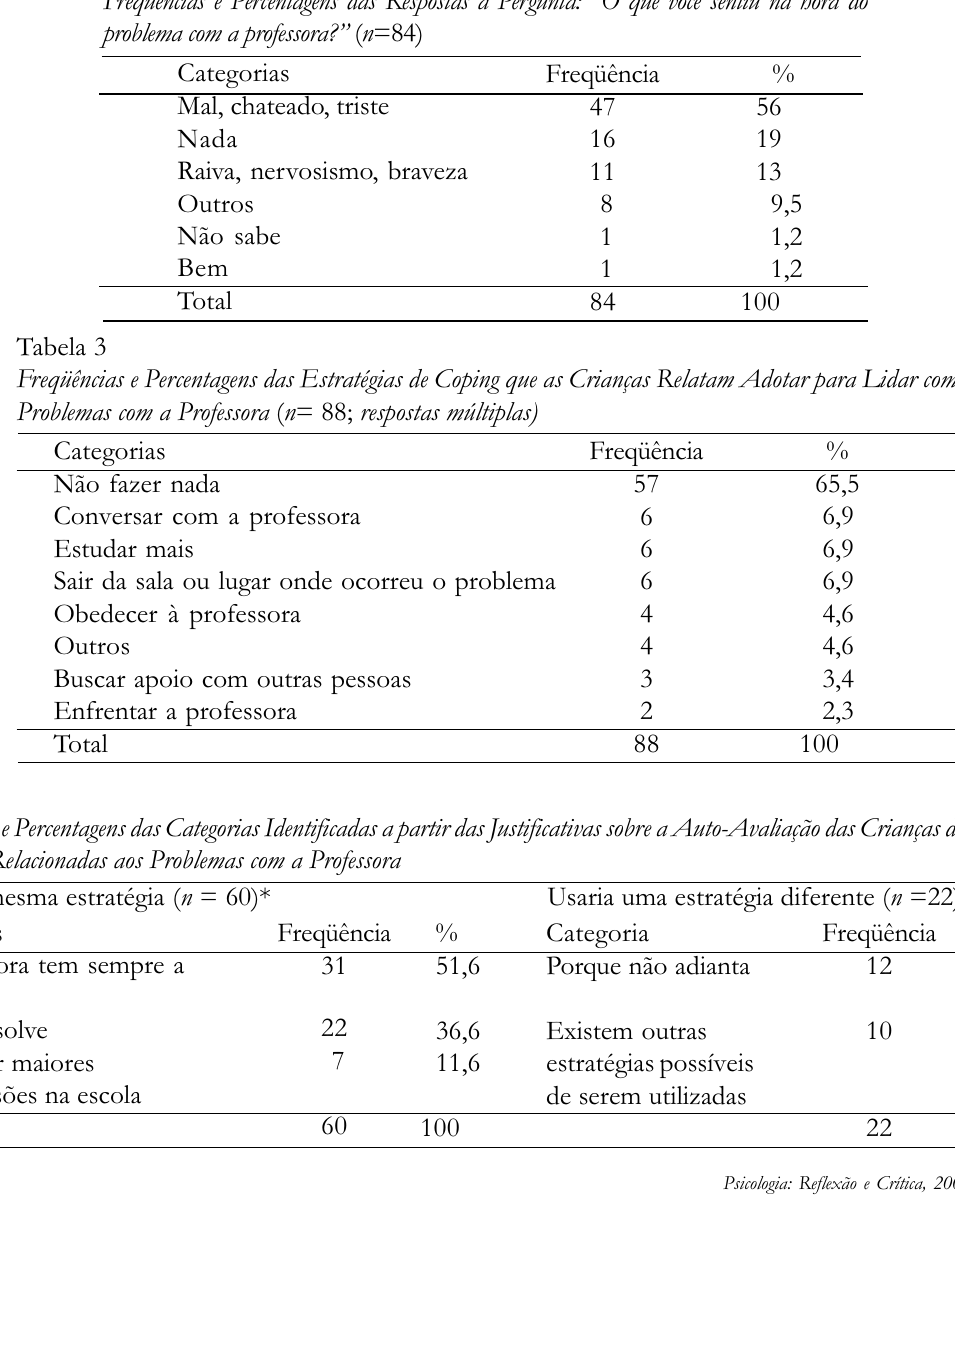
A Tabela 2 mostra o relato das crian(cid:231)as com rela(cid:231)ªo aos seus sentimentos ao perceberem o problema. Cinq(cid:252)enta e